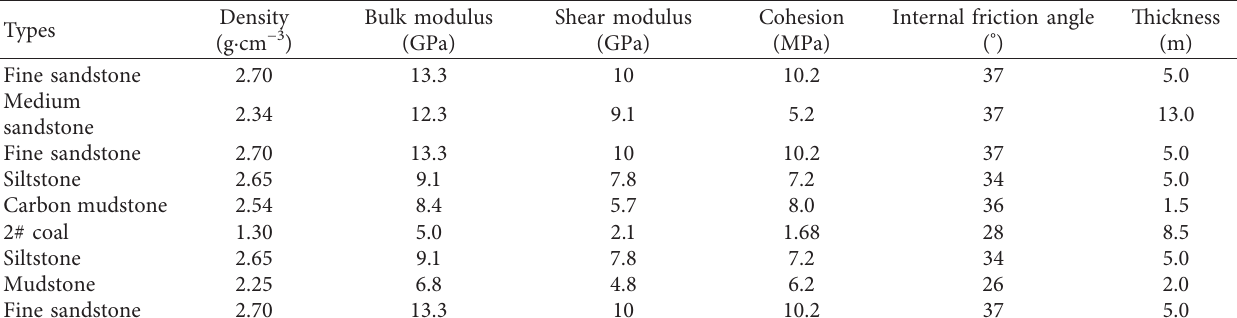
Figure 4: The establishment of a three-dimensional numerical model by FLAC3D software. Table 1: Testing result of coal samples about physical and mechanical